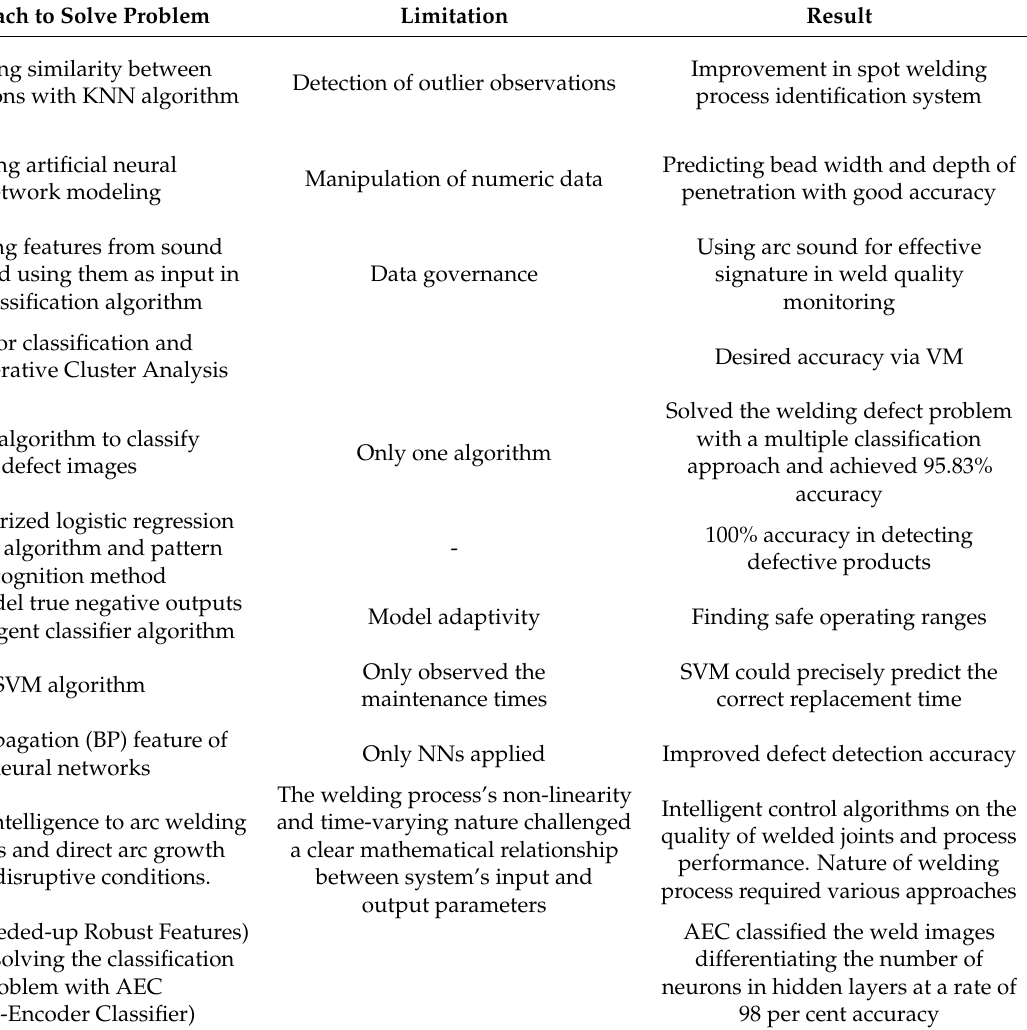
Table 1. Literature review regarding machine learning applications for weld